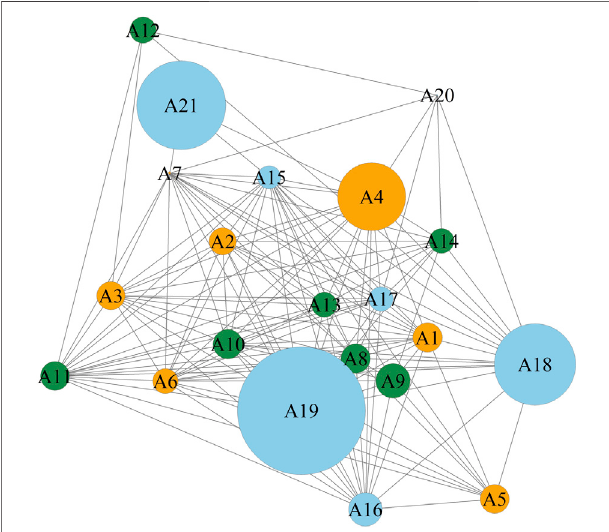
FIGURE 3 | The in fl uencing factors topological diagram of the social- economic-natural compound ecosystem in the GBA.